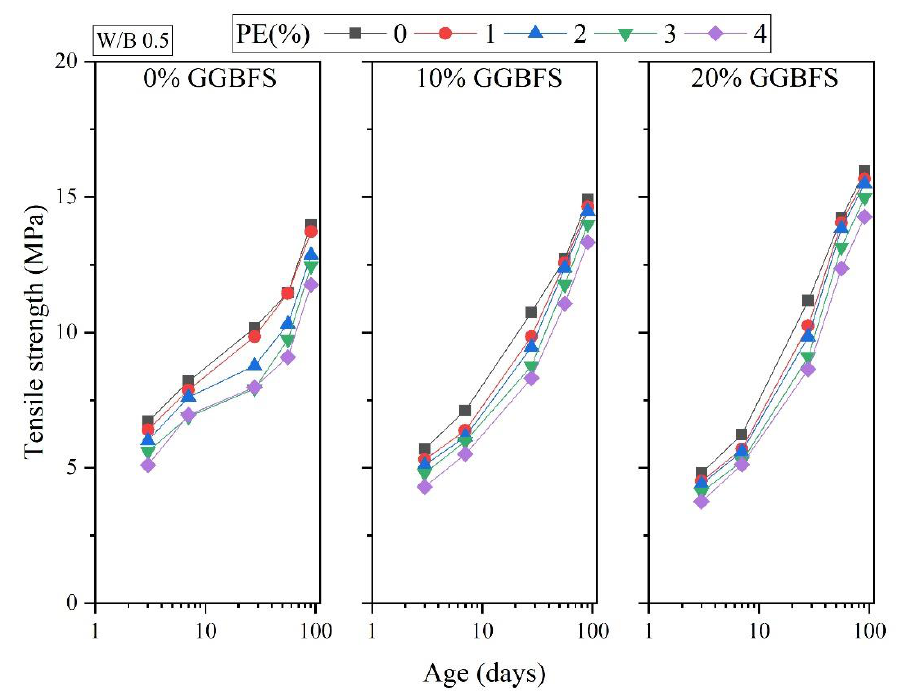
Figure 8. Tensile strength of cement mortars with the addition of different ratios of waste PE and GGBFS replacement.